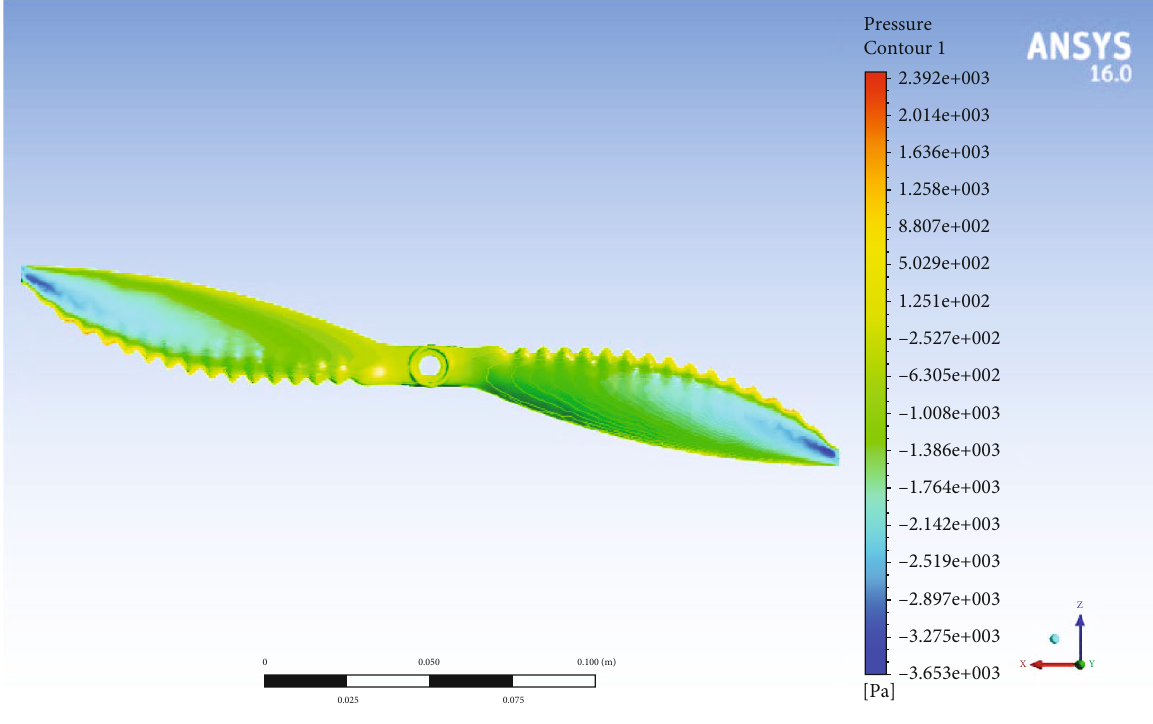
Figure 27: Pressure contour at -75 ° C temperature.